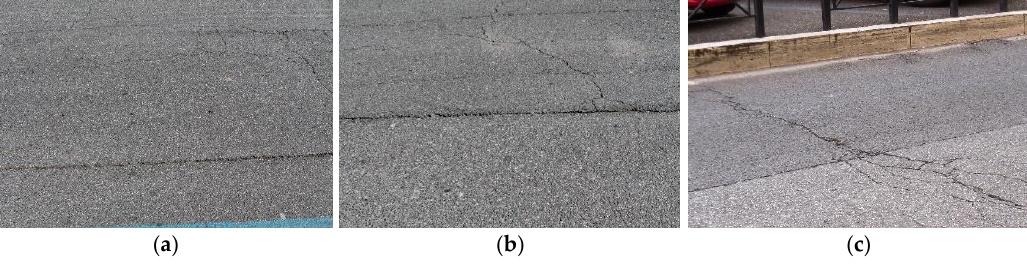
Figure A1. Linear and isolated cracking. ( a ) Low Severity; ( b ) Medium Severity; and ( c ) High Severity.